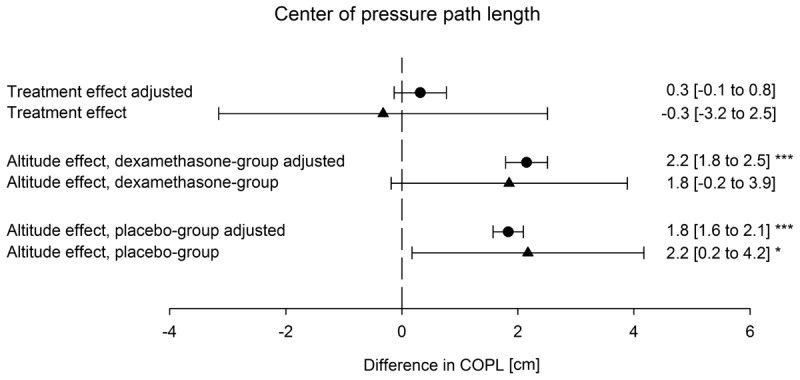
Effect of altitude and of dexamethasone on the center of pressure path length. Altitude effect; difference between the center of pressure path length at 760 m and 3100 m; dexamethasone effect, difference of the altitude effect in the dexamethasone group minus the altitude effect in the placebo group. Mean values and 95% confidence intervals of altitude-induced changes and of differences between dexamethasone and placebo are shown. ∗p-values < 0.05, ∗∗p < 0.01, ∗∗∗p < 0.001. Triangles represent raw values, circles represent values adjusted by multiple regression for age, height, weight, forced expiratory volume in 1 second and acute mountain sickness score.